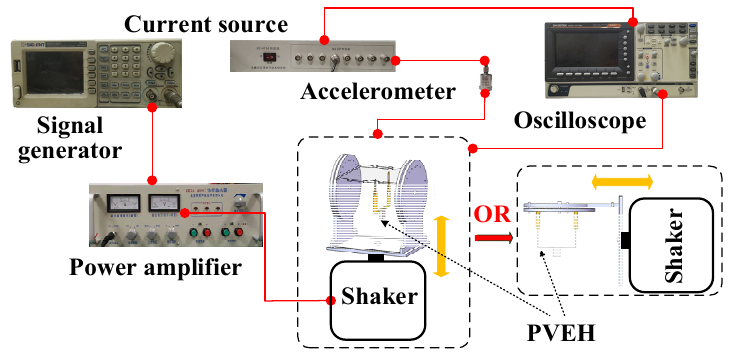
Figure 6. Experimental setup for characterization